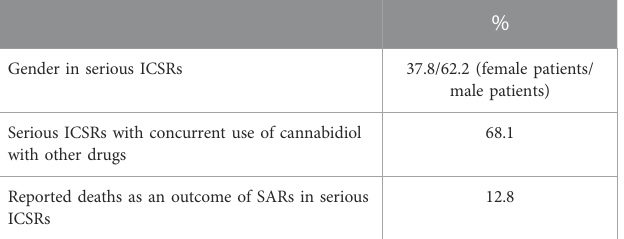
TABLE 2 Suspected adverse reactions (SARs) in the European Economic Area (EEA) and United Kingdom according to gender, concurrent use of cannabidiol with other drugs, and death, reported in serious individual case safety reports (ICSRs), with suspected adverse reactions (SARs) related to the prescription of cannabidiol as an antiepileptic drug in the years 2019 – 2022. The data are reported as a percentage of the total number of ICSRs (N = 47).